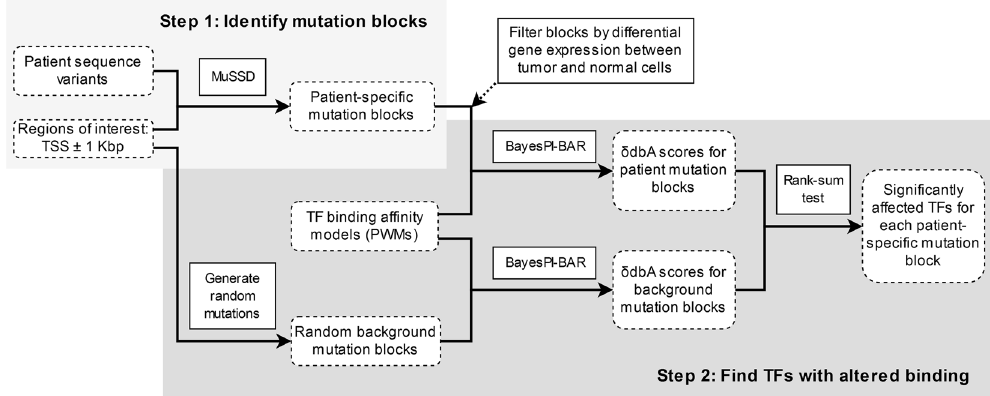
Figure 1. Flowchart of the BayesPI-BAR2 pipeline. The pipeline inputs are: the sequence variants for all patients, the definition of the regions of interest (TSS ± 1 Kbp), and the set of PWMs of known TFs. In Step 1, the patient-specific mutation blocks are identified using the MuSSD algorithm. In Step 2, the TF binding affinity changes in these blocks are predicted by BayesPI-BAR, and compared to that of random background mutations, to obtain a list of significantly affected TFs at each block.